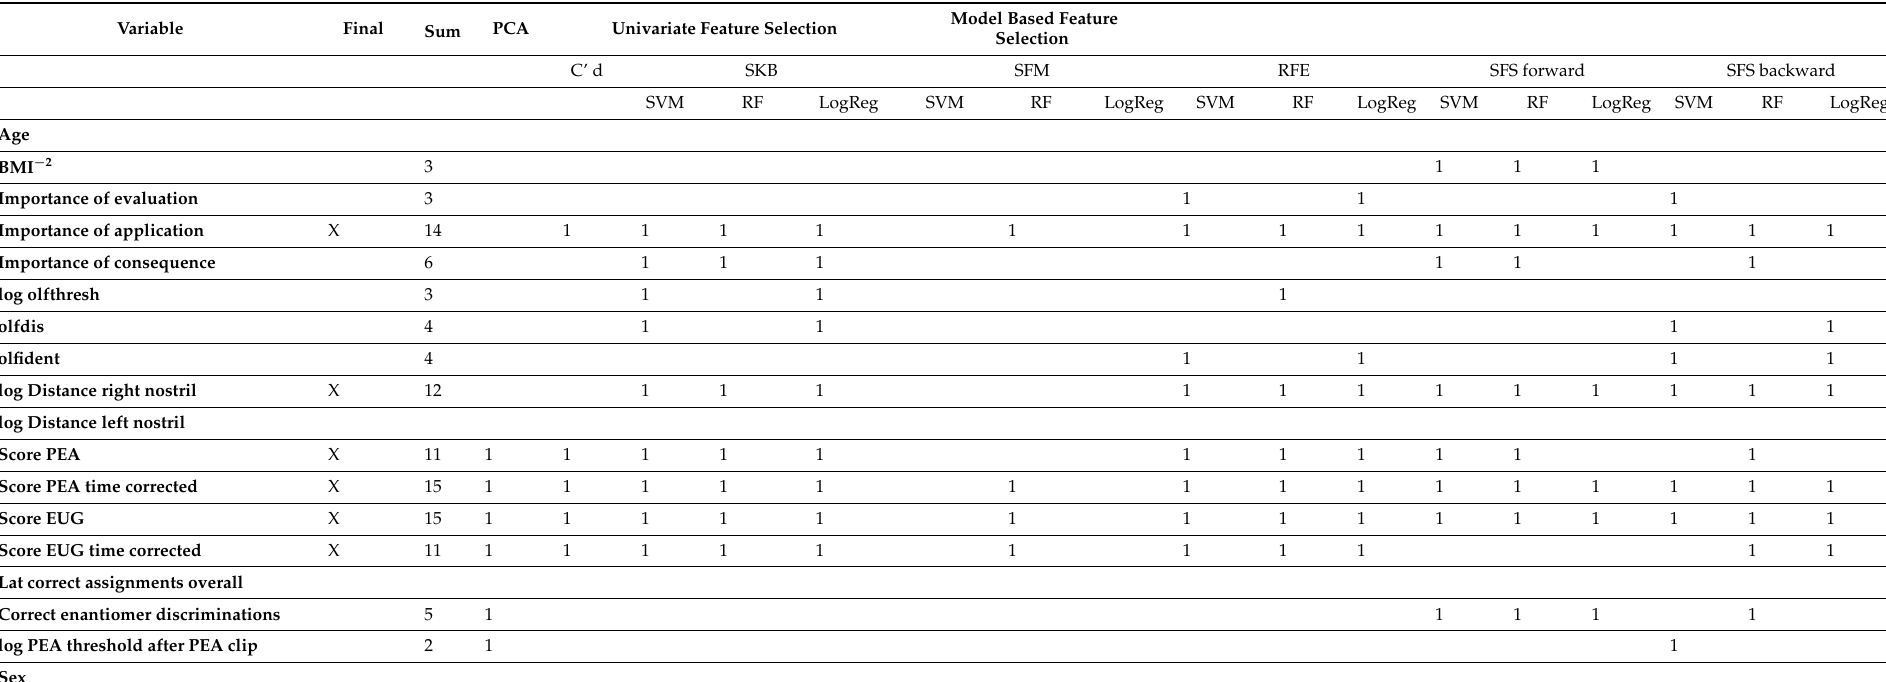
Table 1. Identification of the variables that were most informative in assigning a subject to the k-means clusters. Features were selected according to importance of the variables in the PCA projection of the olfaction-related data, using univariate methods implemented as effect sizes calculated as Cohen’s d (“C’d”) and the “SelectKBest” (SKB) method with model-based grid search to determine how many variables k to be selected, and model-based methods implemented as “SelectFromModel“ (SFM), recursive feature elimination (RFE), and forward and backward sequential feature selection (SFS) used with linear support vector machines (SVM), random forests (RF), and logistic regression (LogReg), in a 100-fold cross-validation scenario run on the initially drawn training data subset. All the methods provided a ranking of the variables for their relevance to the cluster structure, which was subjected to computed ABC analyses, and category “A” containing the most important items was retained. The sum of occurrences in category “A” is shown in the third column from the left. The selection for the final dataset is indicated in the next column to the right of the variable name (“X”). Note that age, sex, and BMI were not used in the PCA projection and therefore could not be selected as relevant features in the PCA. Variable names, if not self-explaining: “olfthresh“ = olfactory threshold to phenyl ethyl alcohol (PEA), “olfdis” = score in the odor discrimination task, “olfident” = score in the odor identification task, “log Distance right/left nostril” = perception of peanut butter odor from a distance, “Score PEA/EUG” = scores in the odor sorting tasks, “Lat correct assignments overall” score in the lateralization